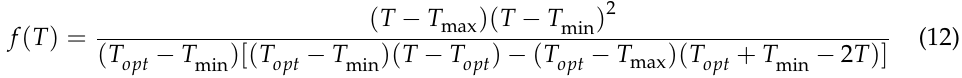
and 50 °C, the temperature influence factor increases linearly with the temperature; when the temperature is greater than 50 ◦ C, the temperature influence factor decreases when the temperature is greater than 50 °C , the temperature influence factor decreases parabolically until it is 0 (Figure 1).